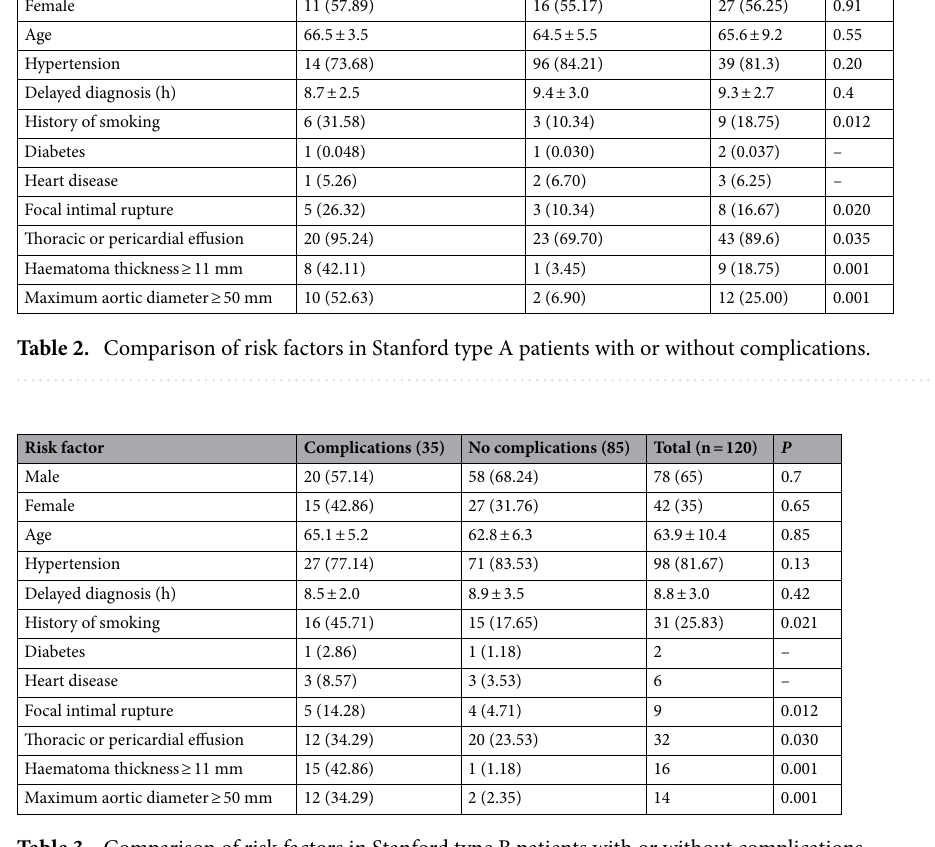
Table 3. Comparison of risk factors in Stanford type B patients with or without complications.